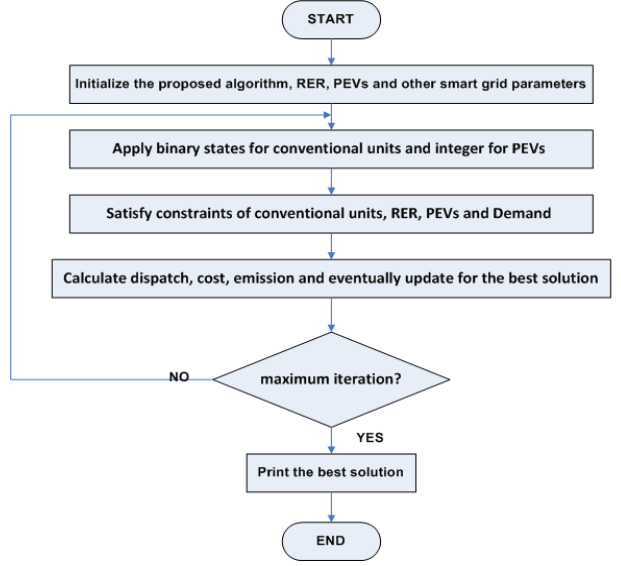
Figure 7. A flowchart for minimizing both cost and emission by using PEVs and RERs.